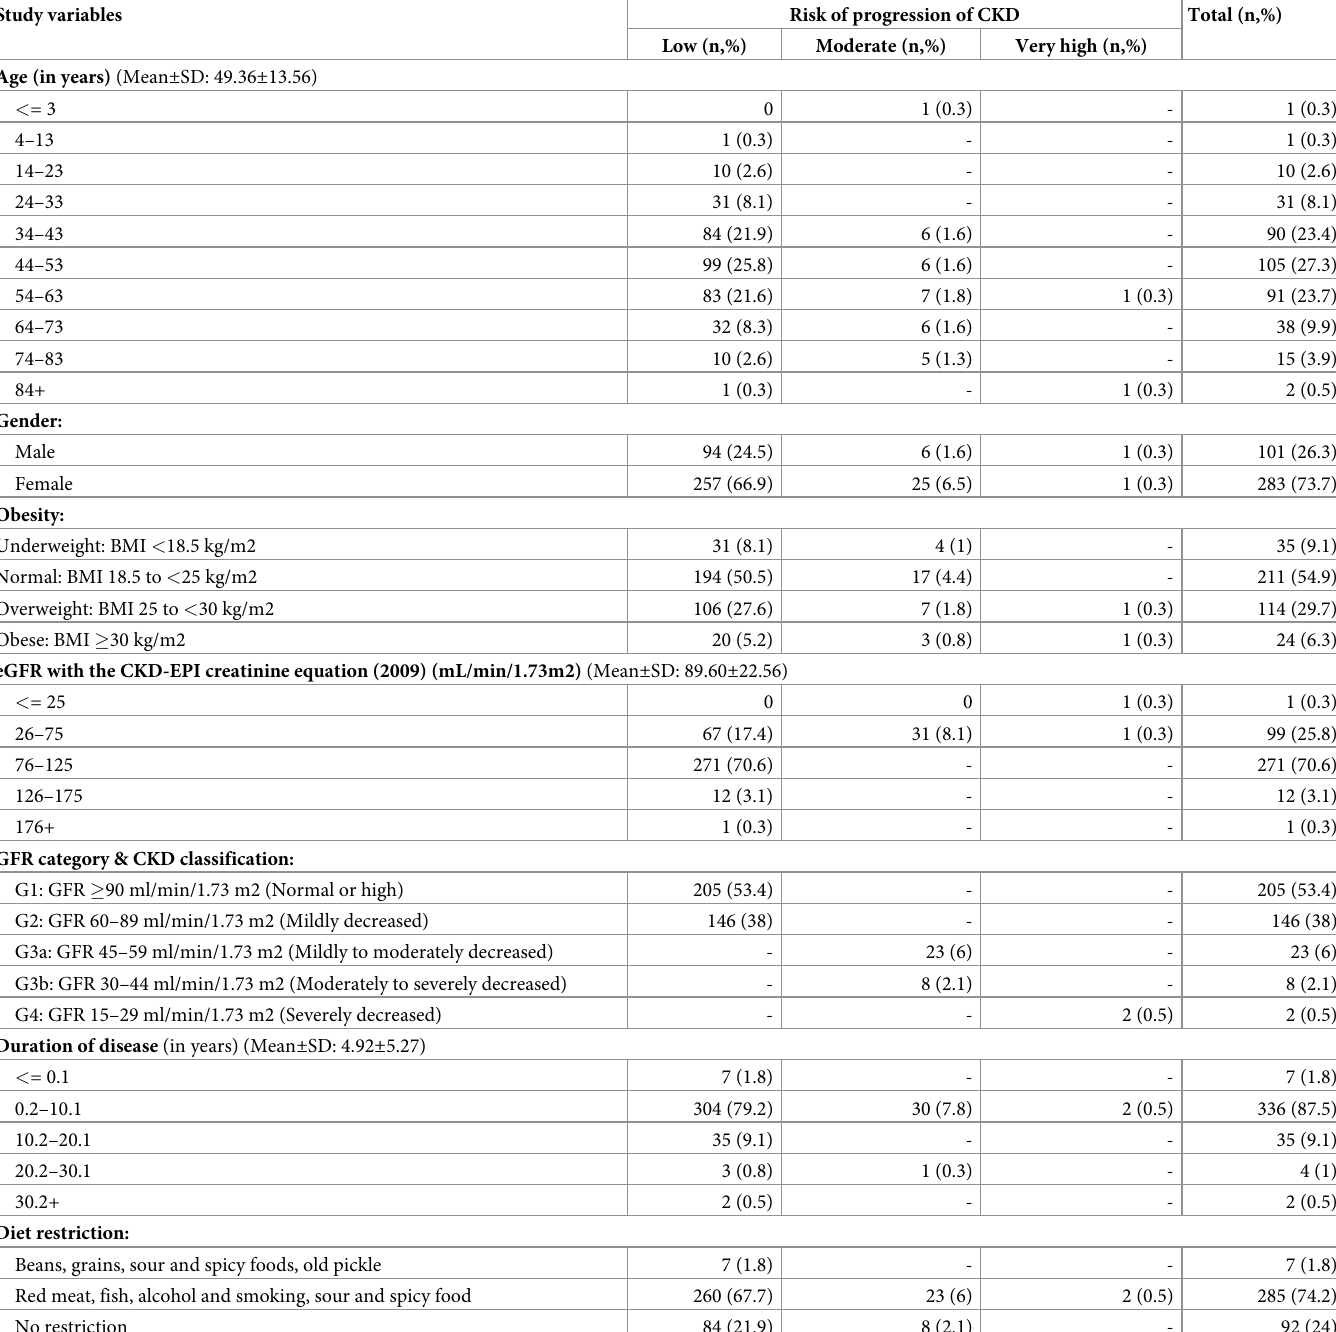
Table 1. Distribution of risk of progression of CKD with demographic and gout related characteristics of study population (n = 384). Study